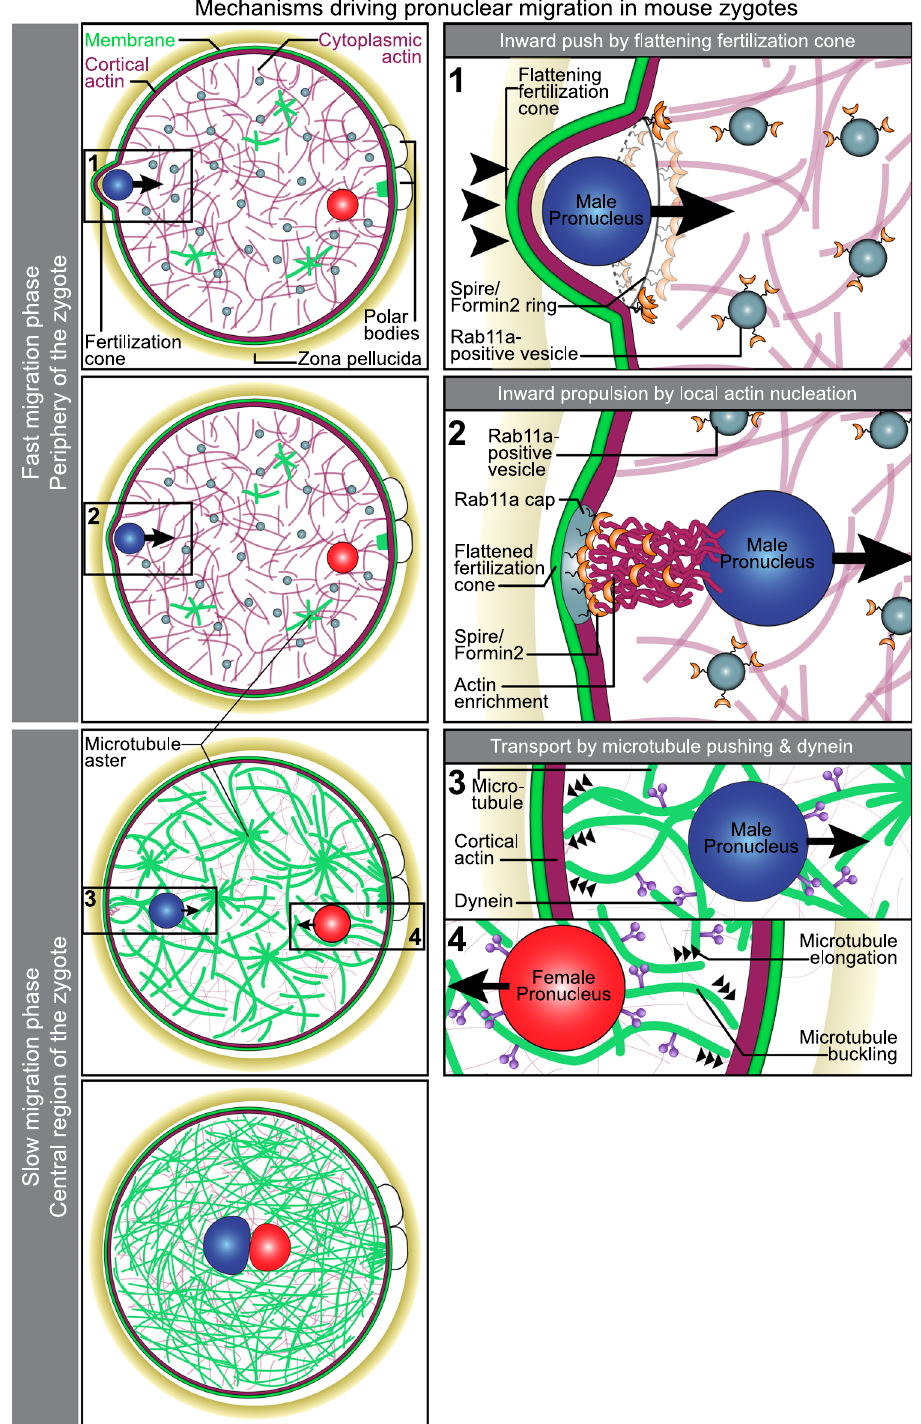
Fig. 10 Model for pronuclear migration in mouse zygotes. Pronuclear migration is initiated by the fl attening of the cone, which moves the male pronucleus inwards. During this stage, actin nucleation factors Formin-2/Spire concentrate as a ring structure at the edge of the shrinking fertilization cone. Next, actin nucleation by the Formin-2/Spire, which are targeted to the fertilization cone by Rab11a-positive vesicles, launches the pronuclei away from the cell surface. Female pronuclei typically assemble further away from the cell surface due to the metaphase II spindle remnant (green microtubule clusters) and their fast migration phase is less pronounced. In the slow migration phase (small arrowheads) microtubules and dynein drive the inwards-directed movement of the two pronuclei. Both mechanisms cooperate in a partially redundant manner to centre the two